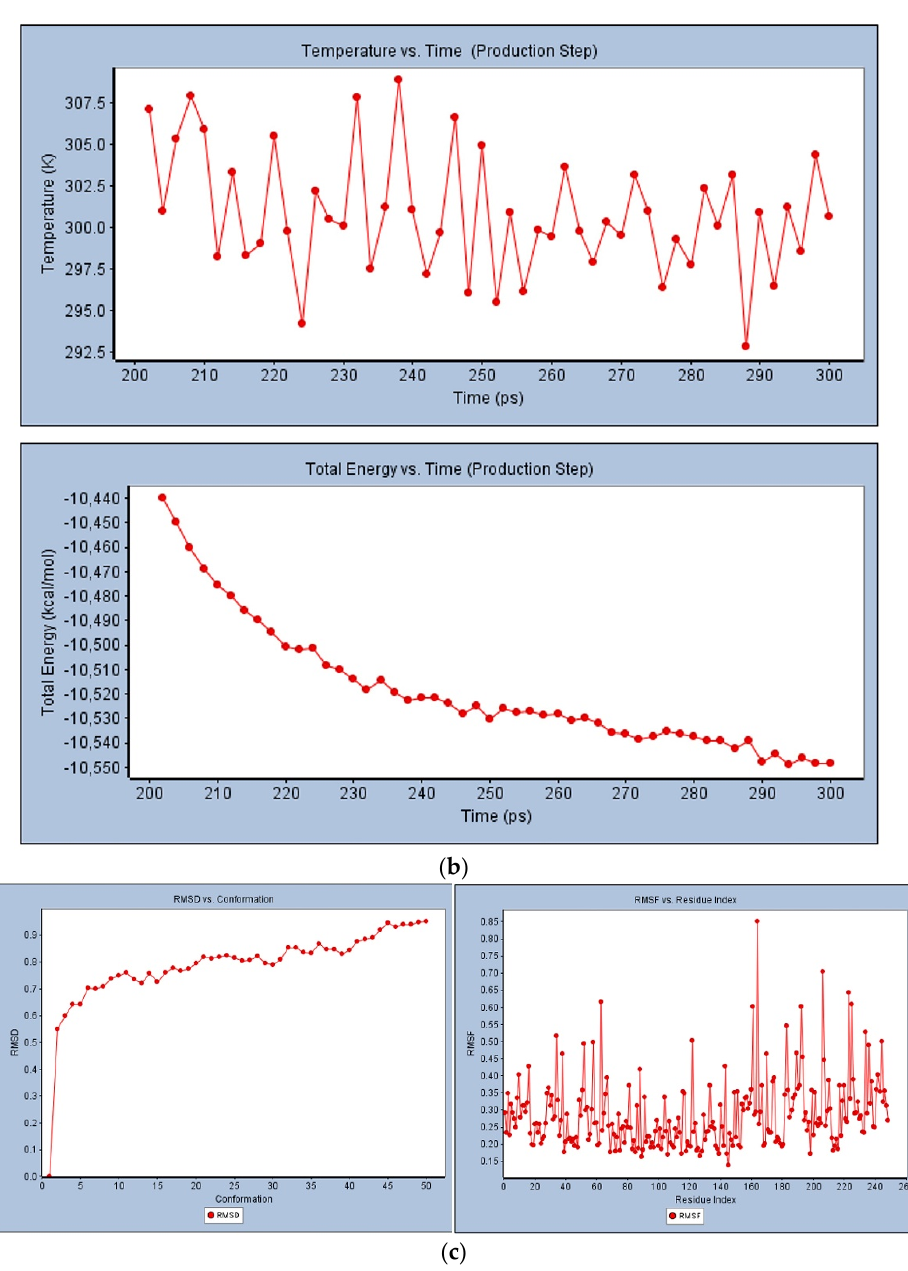
Figure 8. ( a ) Solvation analysis of 2 × 3F protein with (5-(1h-indol-3-yl)-4-pentyl-1,3-oxazole-2-carboxylic acid. ( b ) Temperature and total energy analysis of 2 × 3F protein with (5-(1h-indol-3-yl)-4-pentyl-1,3-oxazole-2-carboxylic acid. ( c ) RMSD and RSMF analysis of 2 × 3F protein with (5-(1h-indol-3-yl)-4-pentyl-1,3-oxazole-2-carboxylic acid. In RMSD analysis (Figure 8c), the unbound protein 2 × 3F and the bound (5-(1h-indol-3-yl)-4-pentyl-1,3-oxazole-2-carboxylic acid with 2 × 3F showed no significant variations in RMSD. These results confirmed that the isolated compound did not induce any major changes in the 2 × 3F protein active site. Further, the RMSF investigated the influence of (5-(1h-indol-3-yl)-4-pentyl-1,3-oxazole-2-carboxylic binding on the flexible region of the targeted protein 2 × 3F. The RMSF results showed that the active sites of amino acids (from 30 to 200 regions) in the 2 × 3F complex did not show any fluctuations when compared with the unbound protein 2 × 3F (Figure 8c). In conclusion, the docked (5-(1h-indol-3-yl)-